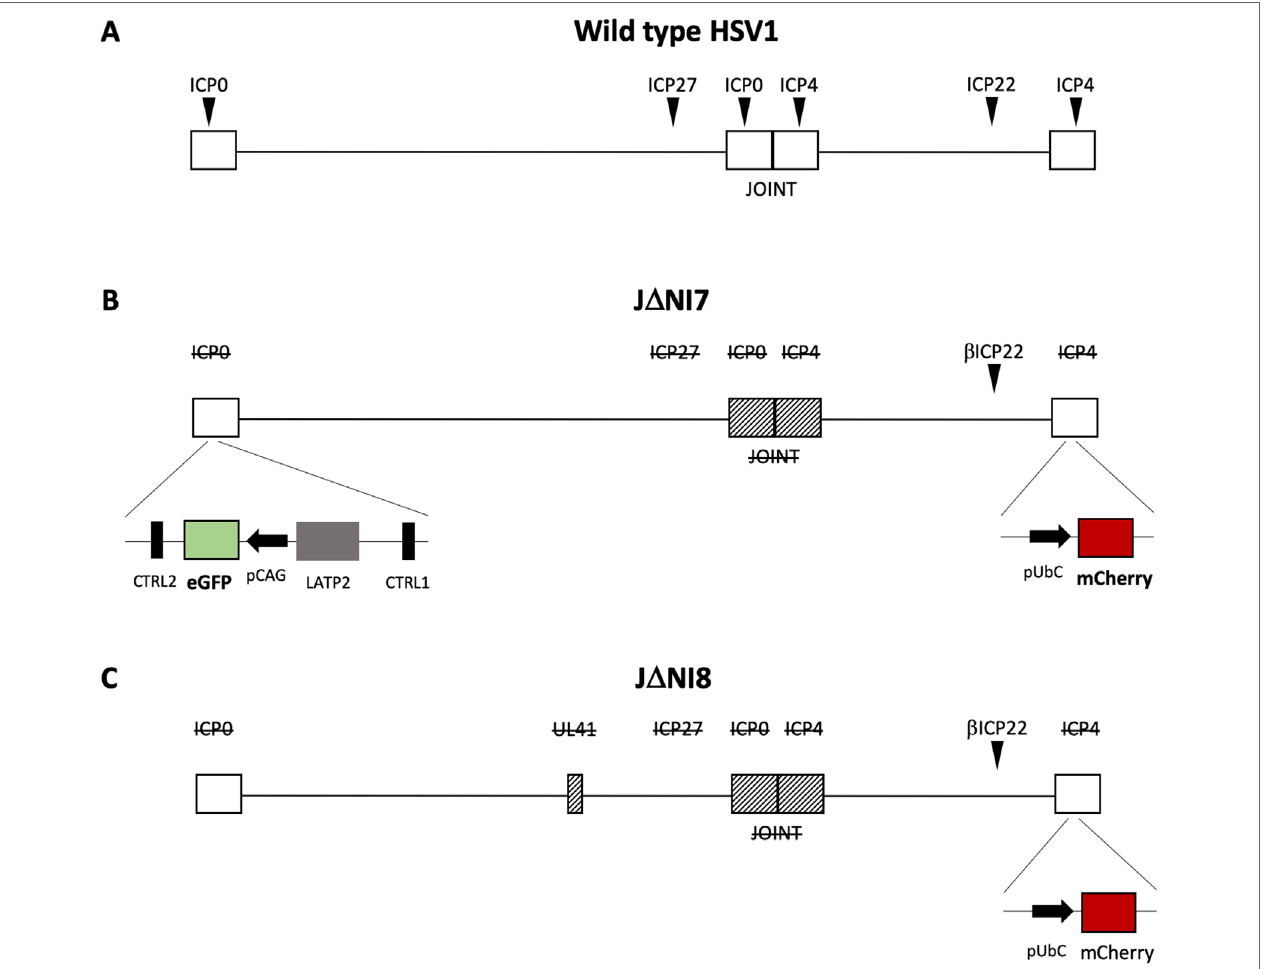
FIGURE 1 | Schematic drawing of the genomes of new HSV-1 vectors. Compared to the wild-type genome (A) , the derivative vectors JDNI7 (B) and JDNI8 (C) are deleted for the joint region and the ICP0, ICP4, and ICP27 immediate-early genes, while the ICP22 immediate-early gene is converted to early-expression kinetics by promoter modification. Moreover, both viral backbones are engineered for the insertion of a ubiquitin C promoter (UbCp)-mCherry cassette within the ICP4 locus. The JDNI7 (B) backbone is further modified by the insertion of a CAG promoter-eGFP expression cassette into the LAT (Latency Associated Transcript) intron region, flanked by the LATP2 enhancer region, and CTCF-binding motifs (CTRL2). The last generation of HSV-based vectors, JDNI8 (C) , is also deleted for UL41, the gene encoding the virion host shutoff (vhs)